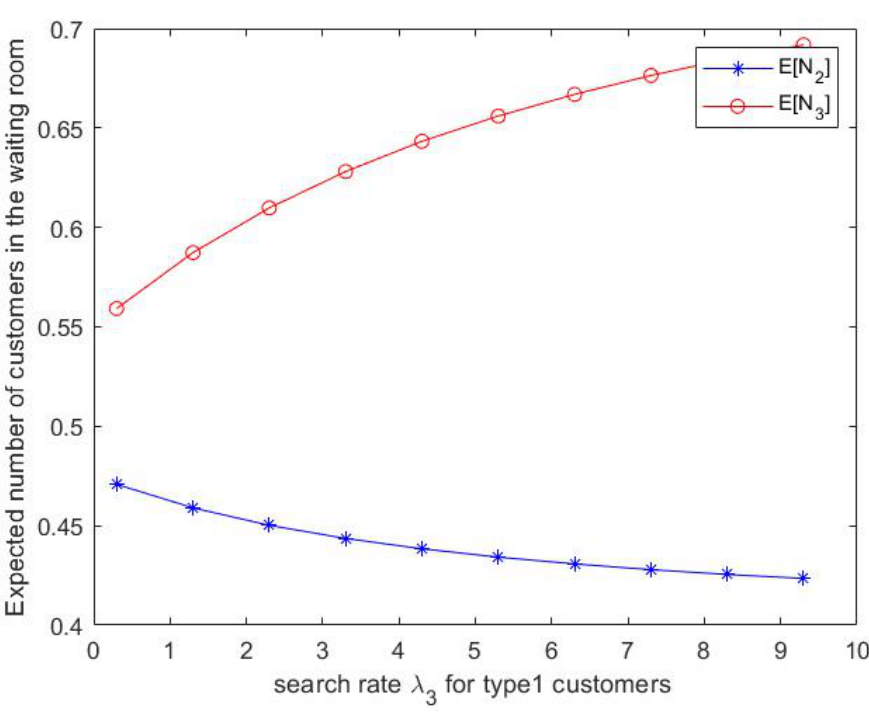
Figure 12. Effect of λ 3 on expected number of type 2,3 customers in waiting room 2,3.